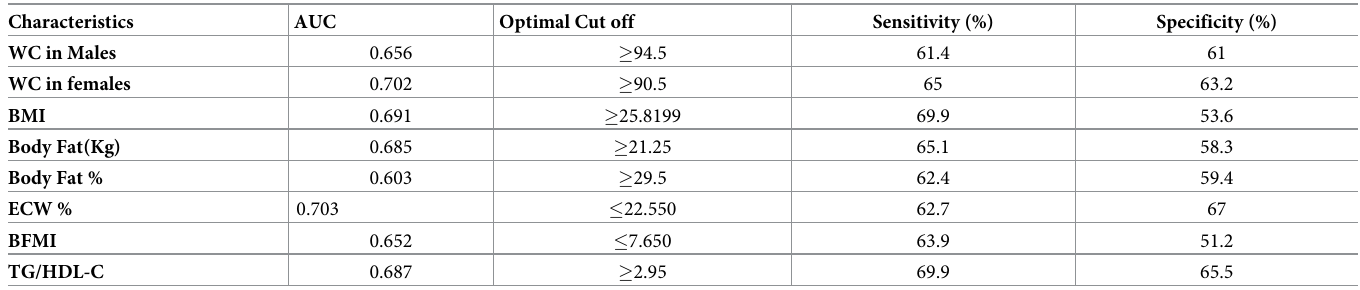
The optimal cutoff points were chosen based on the maximization of the sensitivity and specificity product.